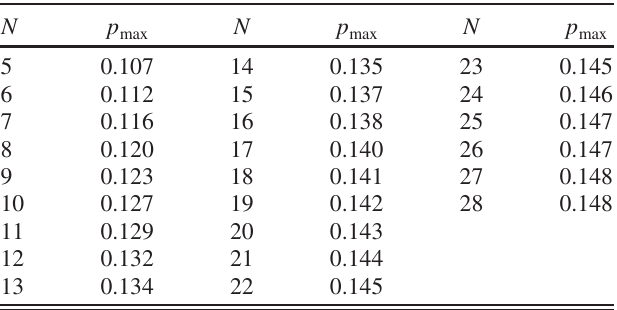
TABLE II. Robustness of nonlocality to white noise in the